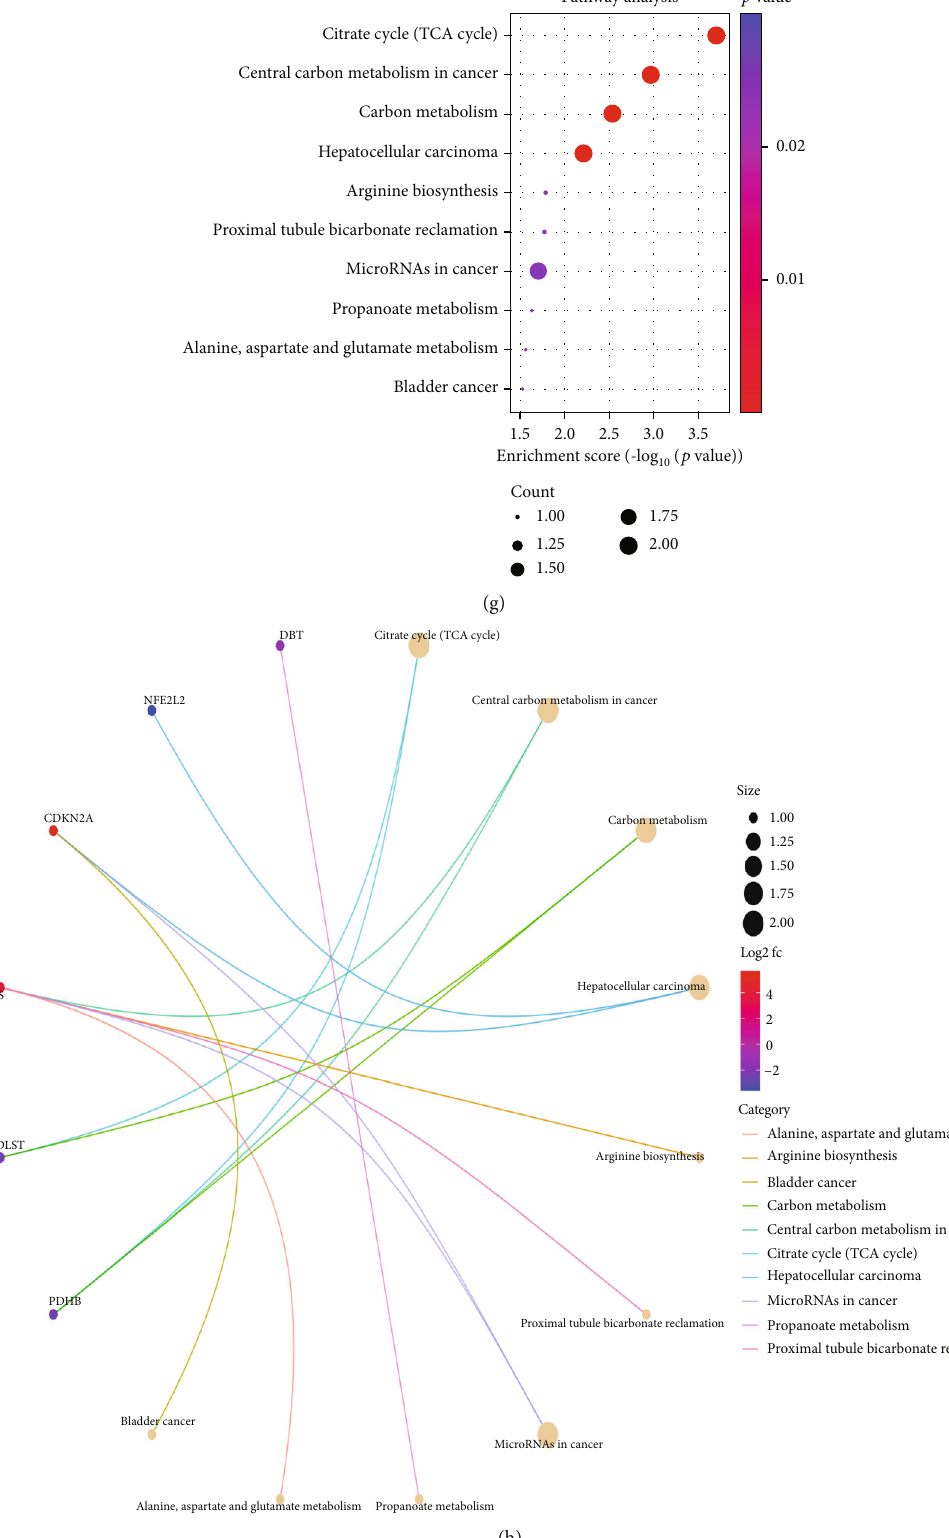
Figure 5: Enrichment analysis. (a) BP enrichment bubble map. (b) BP enrichment arc map. (c) CC enrichment bubble map. (d) CC enrichment arc map. (e) MF enrichment bubble map. (f) MF enrichment arc diagram. (g) KEGG enrichment bubble diagram. (h) KEGG enrichment arc